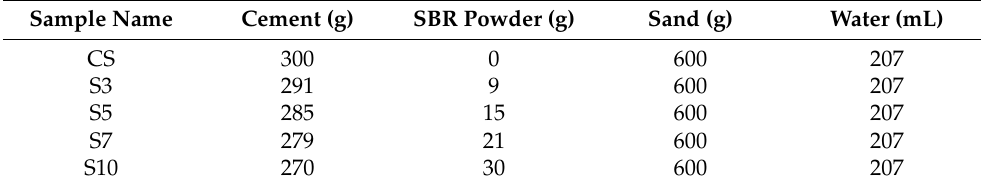
Table 5. Drying Shrinkage Test: Mix Proportions and Shrinkages at 33 ◦ C (91.4 ◦ F) and 57% RH (ASTM C490 and ASTM